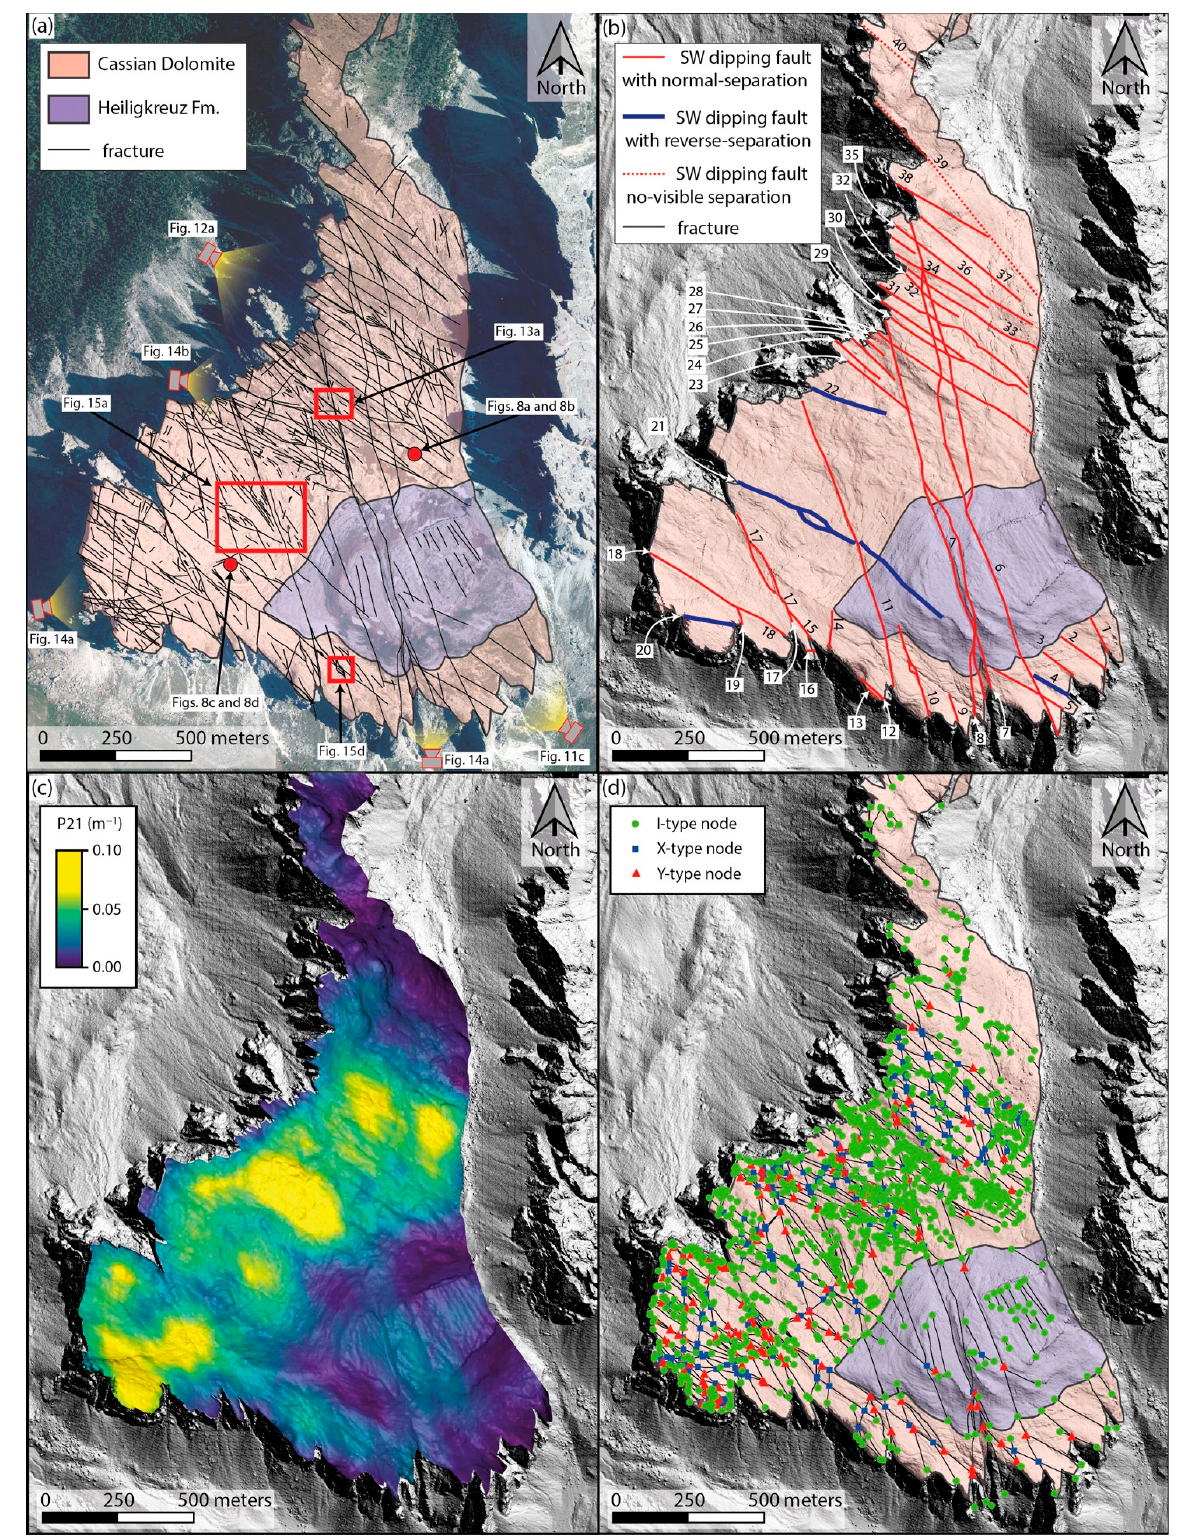
Figure 5. Orthorectified view of the analysis of ( a ) fracture orientation, ( b ) fracture displace- ment/kinematic, ( c ) fracture areal intensity (P21)., and ( d ) fracture network topology. The AGEA2012 orthoimage and 1 m resolution LiDAR DEM used as background are retrievable from [28].